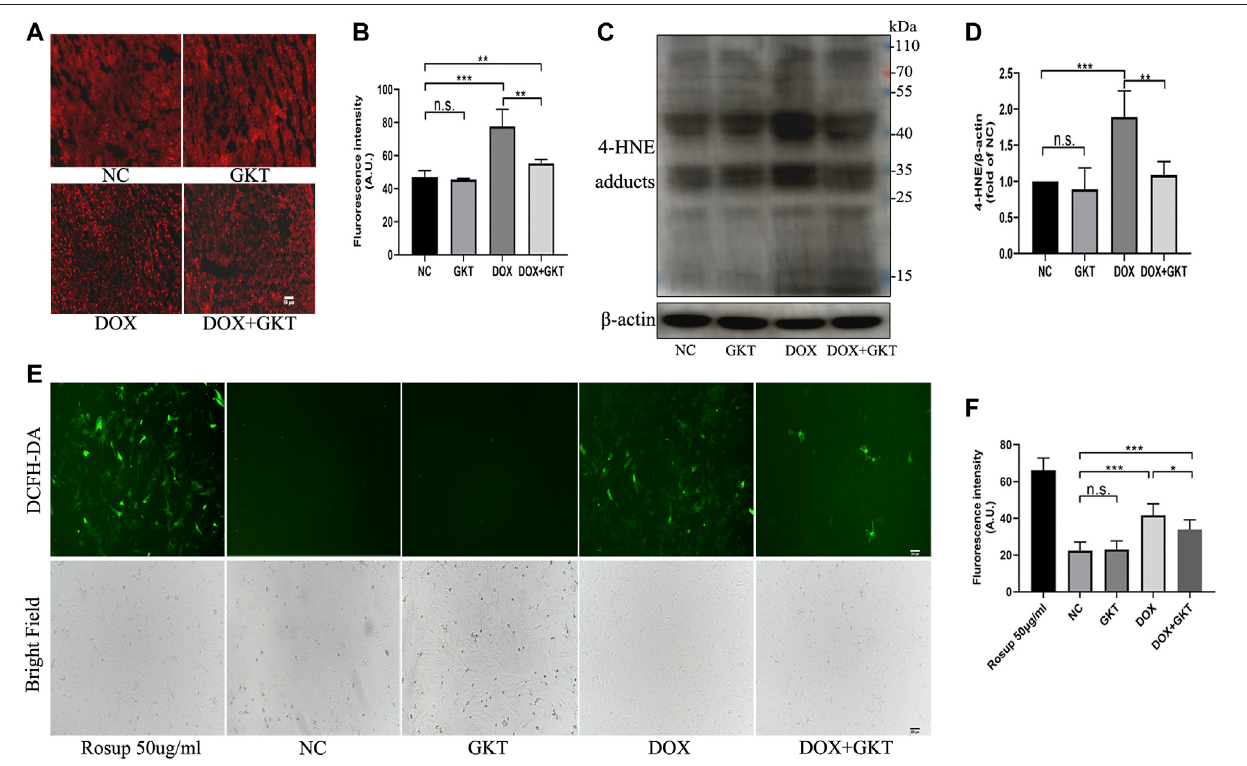
FIGURE 3 | GKT137831 ameliorated oxidative stress both in vivo and in vitro . (A,B) Representative images of myocardial tissue with DHE staining (scar bar = 50 µm) and fl uorescence intensity analysis in different groups ( n = 5 per group). (C,D) Representative images of western blotting for 4-HNE and quanti fi cations by densitometric analysis, β -actin was used as a loading control ( n = 5 per group). (E,F) Intracellular ROS generation in NRCMs was detected using DCFH-DA probe then evaluated by fl uorescence microscopy (scar bar = 200 µm) and fl uorescence intensity analysis. NRCMs were pretreated with GKT (5 μ M) for 1 h, and then treated with DOX (2 μ M) for 24 h. Rosup was used as a ROS positive control ( n = 3). * p < 0.05, ** p < 0.01, *** p < 0.001, n. s., not signi fi cant. Abbreviations: DOX, doxorubicin; GKT, GKT137831; DHE, dihydroethidium: 4-HNE, 4-hydroxynonenal: DCFH-DA, dichlorodihydro fl uorescein diacetate; AU, arbitrary